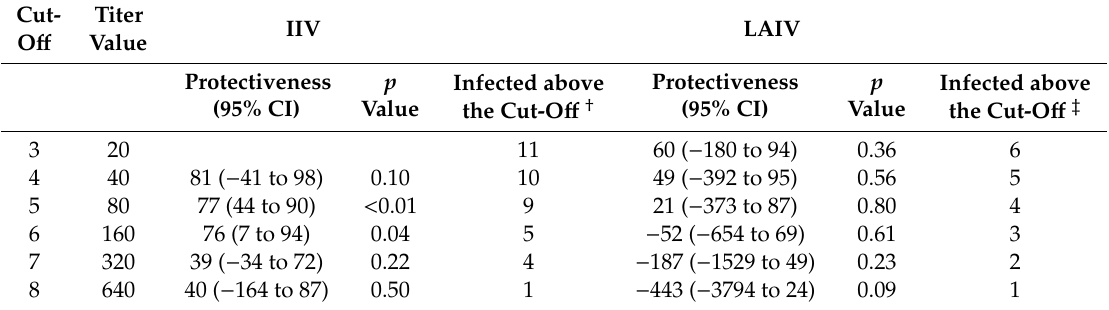
Table 4. HAI protectiveness against